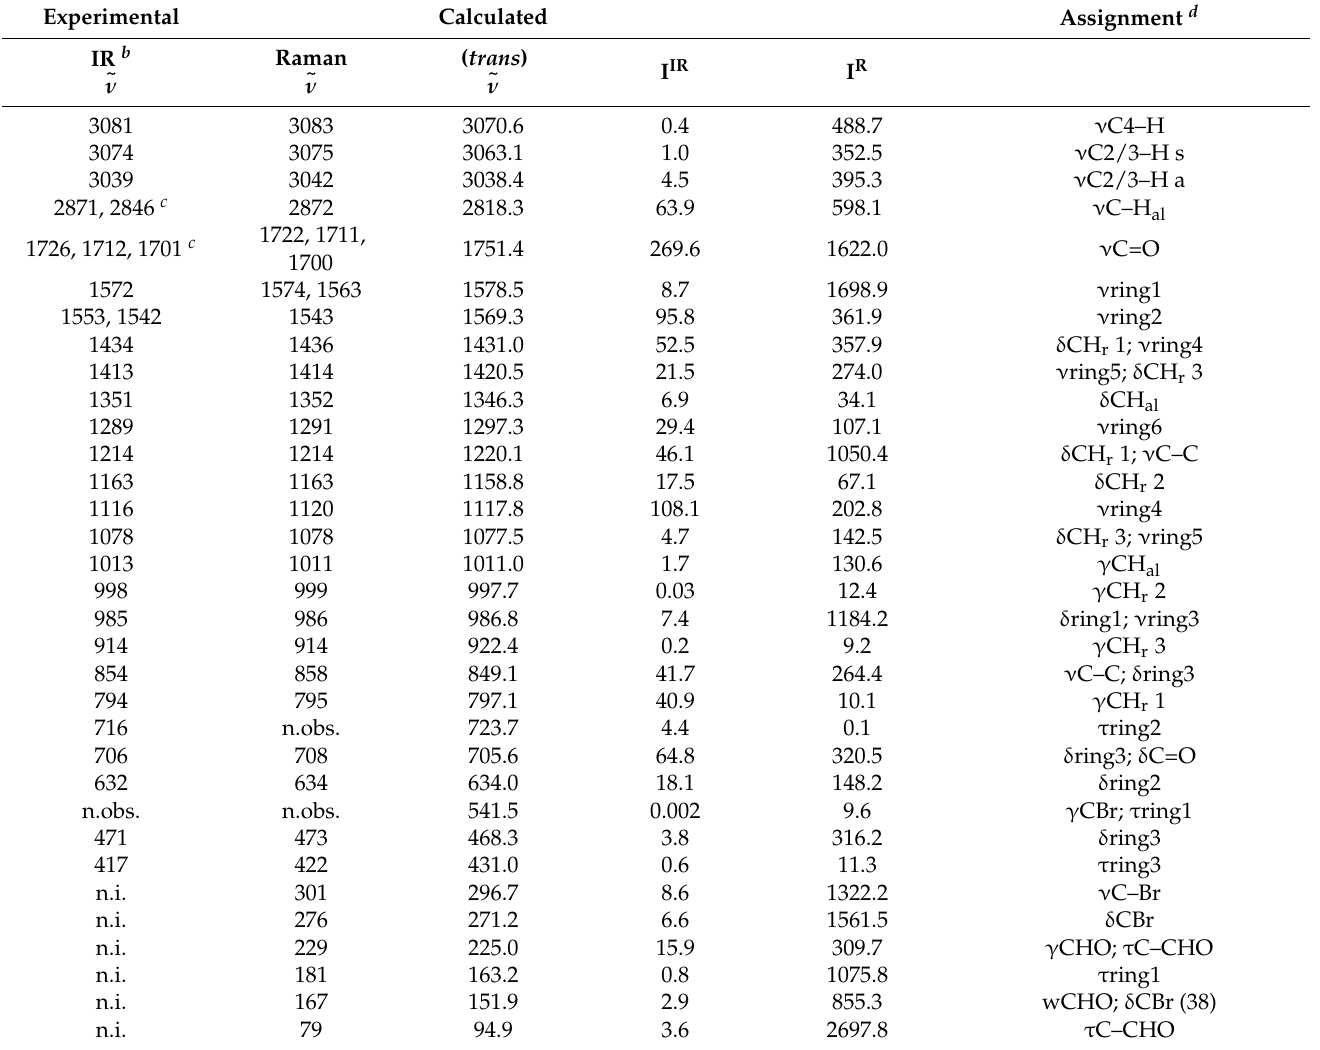
Table 6. Assignment of the room temperature IR and Raman spectra of BPCA crystal a